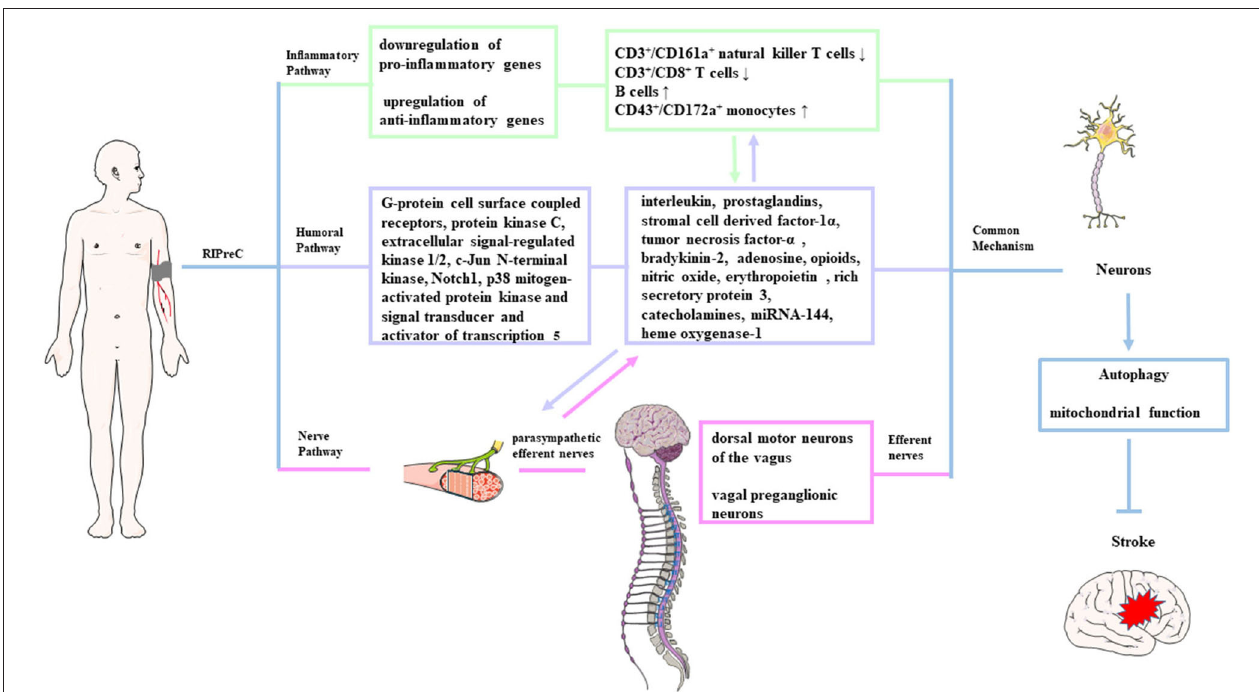
FIGURE 1 | Possible mechanisms of remote ischemic preconditioning. The protective signals generated from the remote organ(s) are transmitted to the brain possibly through three pathways: neuronal (pink shading), humoral (purple shading), and immunological pathway (green shading). After being transmitted to the brain through the above three pathways, these signals induce autophagy activation and functional changes in the mitochondria, which is called a common signaling